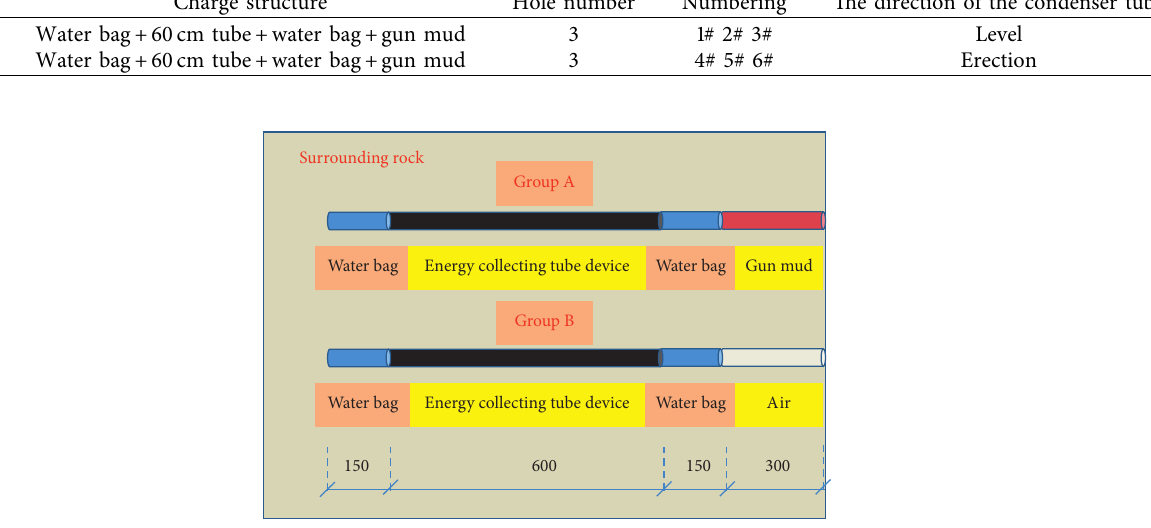
Figure 2: Dimensional parameters of gun hole charging structure (unit: Table 2: Estimating table of the material required for joint-hole plugging test.